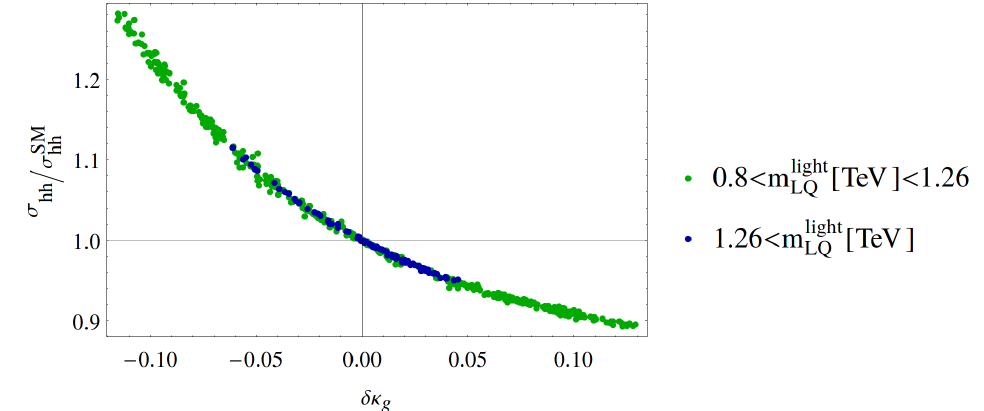
Figure 14. LO σ hh normalized with respect to the SM one, as function of δκ g , in color values of the lightest LQ mass m light LQ